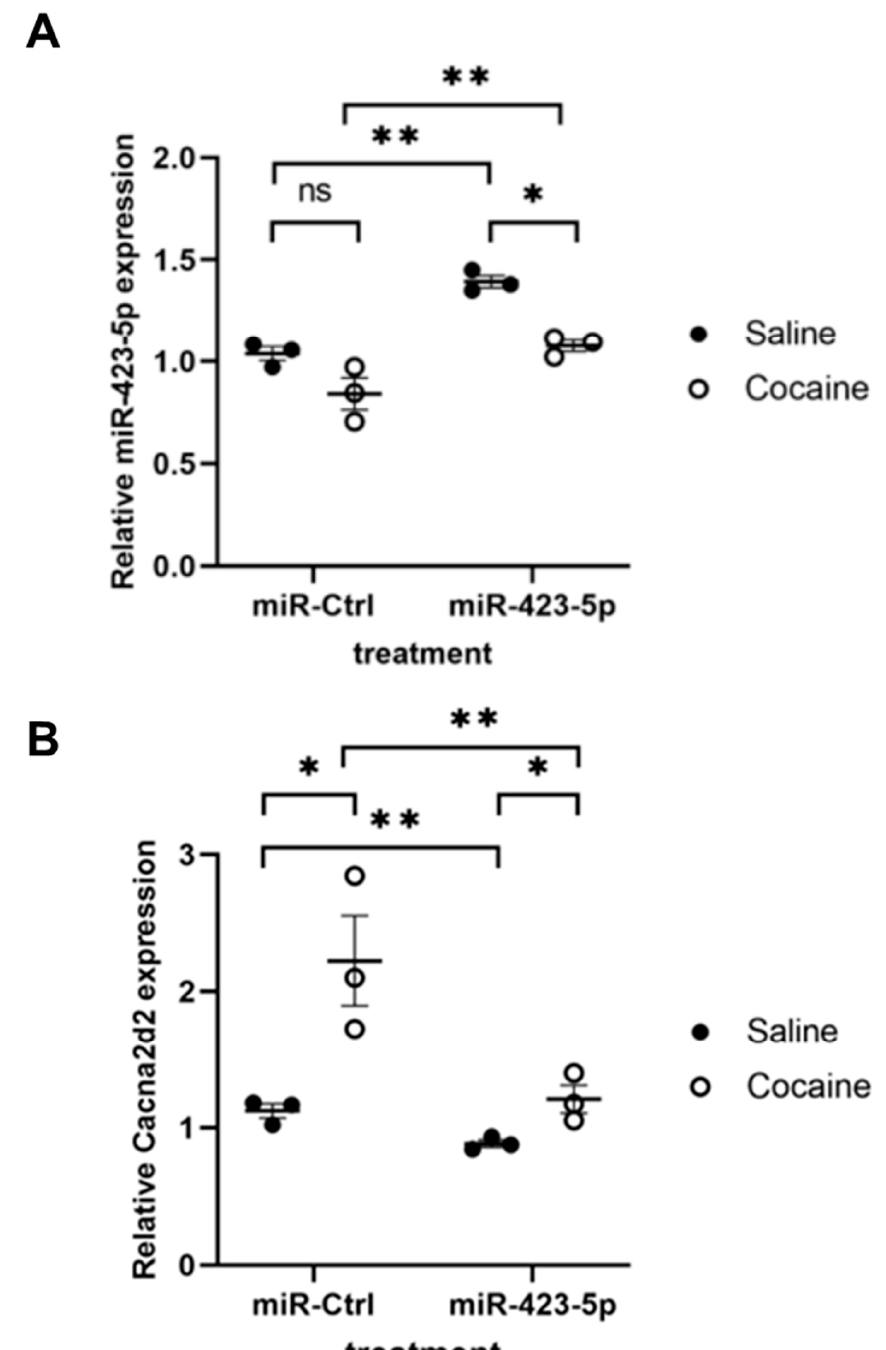
Figure 6. Treatment with miR-423-5p vector leads to increased expression of miR-423 and decreased expression of Cacna2d2 in mouse aortas. ( A ) Quantitative real-time PCR (qRT-PCR) analysis shows that the systemic treatment of mice with lentivirus expressing tmiR-423-5p from the smooth muscle- specific promoter Sm22a leads to an elevation of miR-423-5p compared to the control mice (vector control treatment) when measured in the aortas harvested from the cocaine (open circles) and saline (closed circles) treated mice. (ns: not significant; * p < 0.05 vs. miR-Ctrl; ** p < 0.05 vs. Saline). ( B ) qRT-PCR analysis also shows that miR-423-5p overexpression decreases Cacna2d2 expression in aortas compared with vector control treated mice in the absence or presence of cocaine. Student’s two tailed t -test was used for all statistical analysis (* p < 0.05 vs. saline; ** p < 0.05 vs. miR-Ctrl).